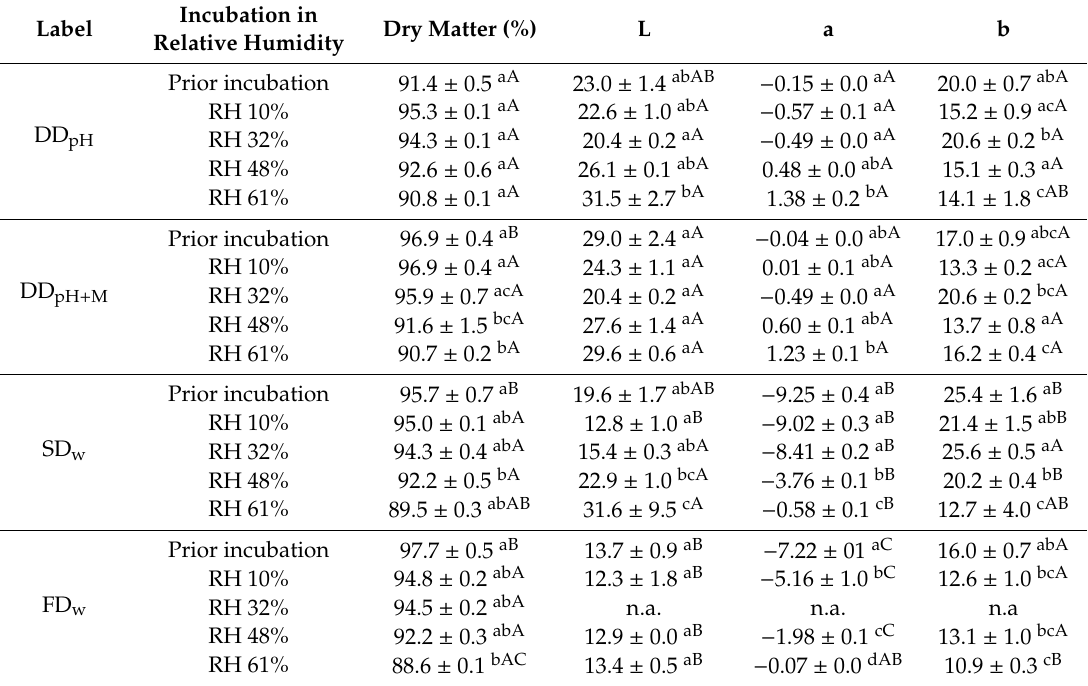
Table 1. Dry matter and color attributes for thylakoid powders dried in di ff erent ways after 8 months storage in varying relative humidity.